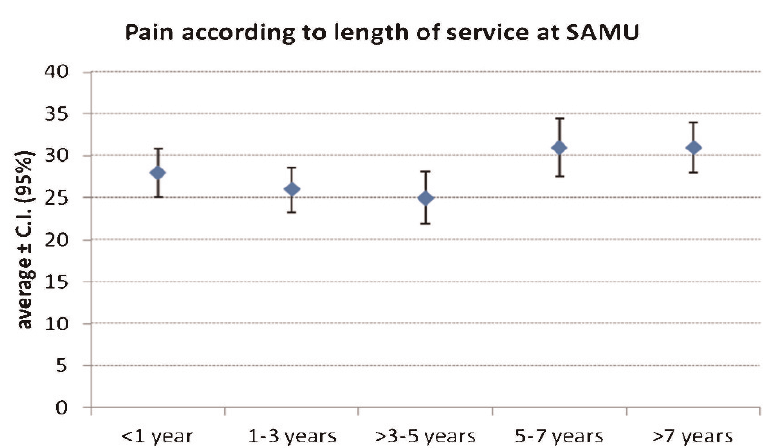
Figure 2 - Graph showing the distribution of pain among physicians with different lengths of service